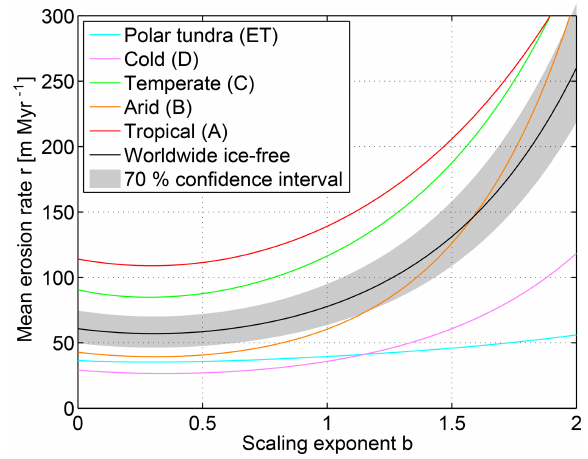
Figure 9. Results of our approach assuming a nonlinear relation- ship between relief and erosion rate (Eq.